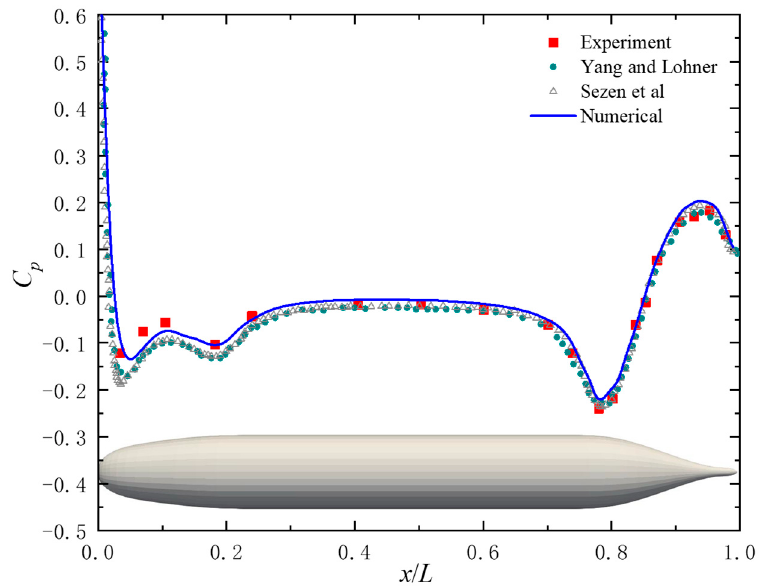
Figure 6. Nondimensional pressure coefficient distribution along SUBOFF-AFF-1.